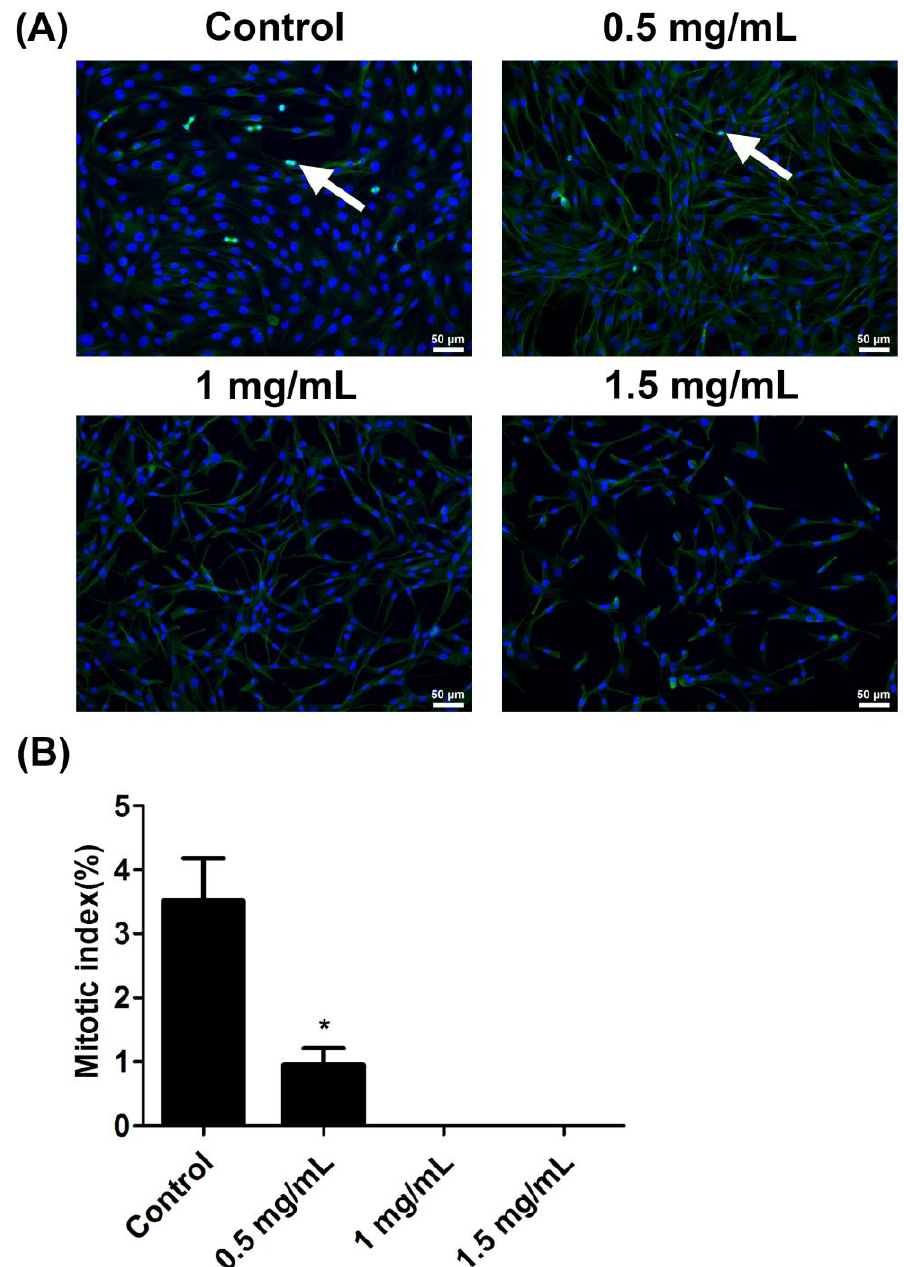
Figure 4. Lidocaine inhibited mitosis in tendon cells. ( A ) Tendon cells were either left untreated or were treated with 0.5, 1.0, or 1.5 mg/mL lidocaine for 24 h, after which mitosis was observed through immunofluorescence staining. Tubulin was stained green, and nuclei were stained blue. White arrows point to mitotic cells. Scale bar: 50 µ m. ( B ) The numbers of mitotic cells and total cells were counted. The mitotic index was defined as the number of nuclei undergoing mitosis divided by the number of all cells on the coverslip and then multiplied by 100%. Data are presented as the means ± standard errors of the mean of three independent experiments. * p < 0.05.